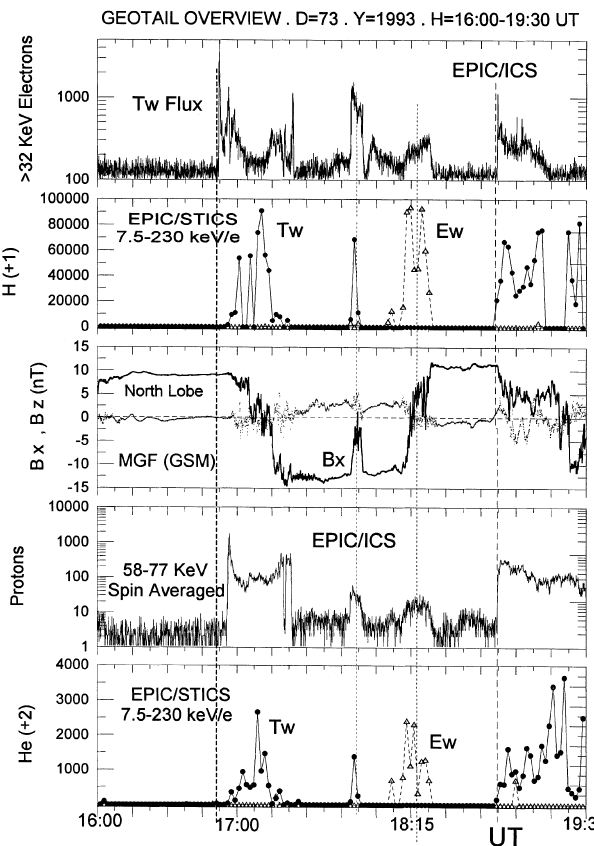
Fig. 1. Overview of the interval 16:00–19:30 UT on day 73, 1993, at X = ) 177 R . Central panel : the B ( solid thick line ) and B ( dashed E x z line ) components of the magnetic field in GSM coordinates at 3-s resolution. First panel : tailward (Tw) flux (which is measured by the sunward-looking sector) of >32-keV electrons. Second and bottom panels : Tw ( solid dotted line ) and earthward (Ew) fluxes of the 7.5– 230-keV/e protons and He ++ , respectively, of the EPIC/STICS sensor. Fourth panel : spin-averaged 58–77-keV energetic protons of the EPIC/ICS sensor. All the particle data are depicted as